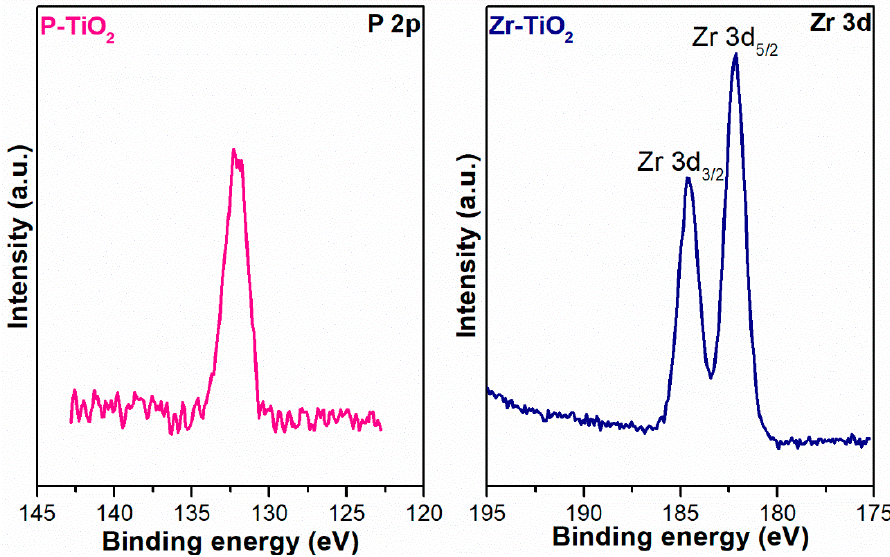
Figure 9. X-ray photoelectron spectra of P 2 p and Zr 3 d of P-TiO 2 and Zr-TiO 2 , respectively.